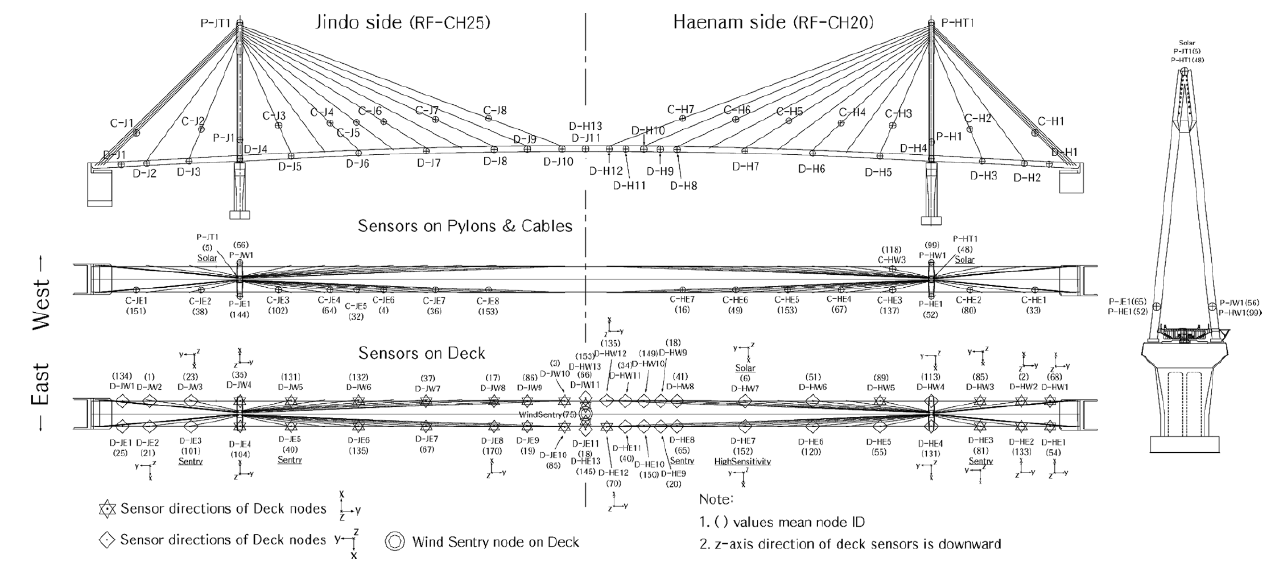
Figure 10. Sensor arrangement on the bridge [163].